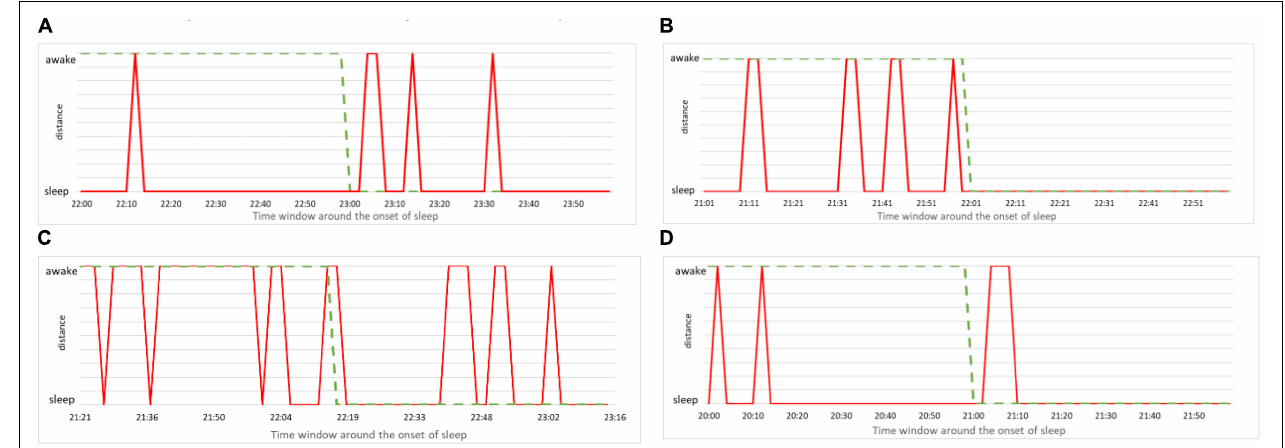
FIGURE 10 | (A) Zoom to the onset of sleep for male subject, 21 years of age. Red line indicates the consciousness status determined by our method as a binary value (sleep or awake) within time window of 1 h prior and 1 h after the self-reported time of falling asleep. Green dashed line is the self-reported information. (B) The